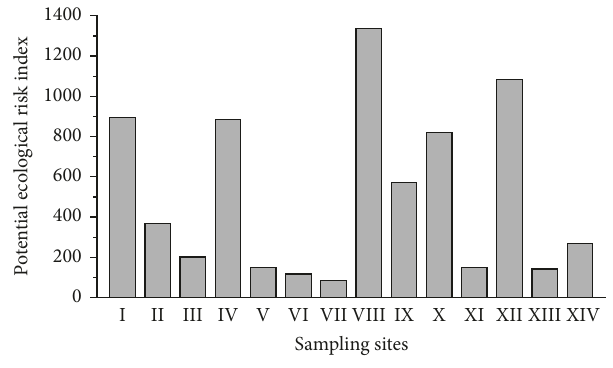
Figure 4: Potential ecological risk indices of soils and sediments from the sampling sites at the La Zacatecana